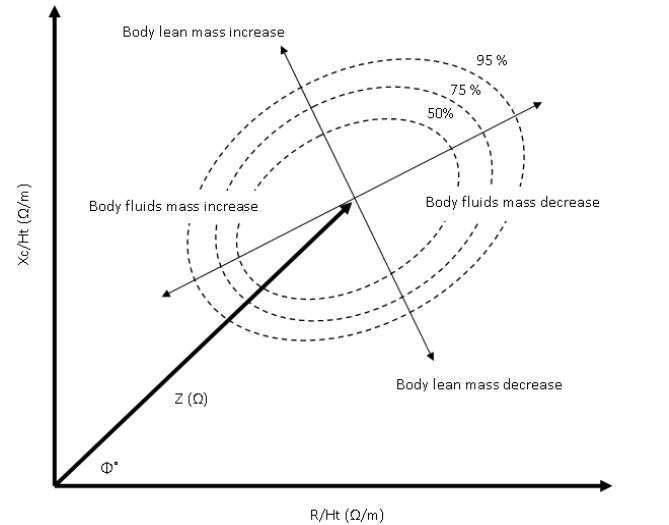
Figure 5. Bioimpedance vector analysis (BIVA) and tolerance